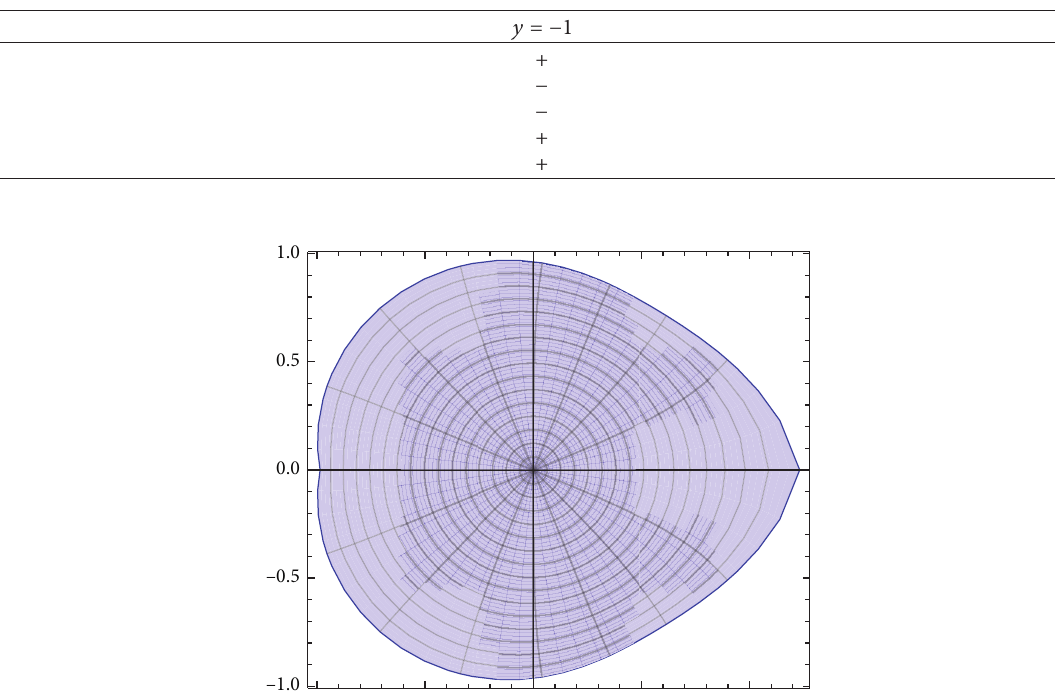
Figure 5: Image of D under the mapping h